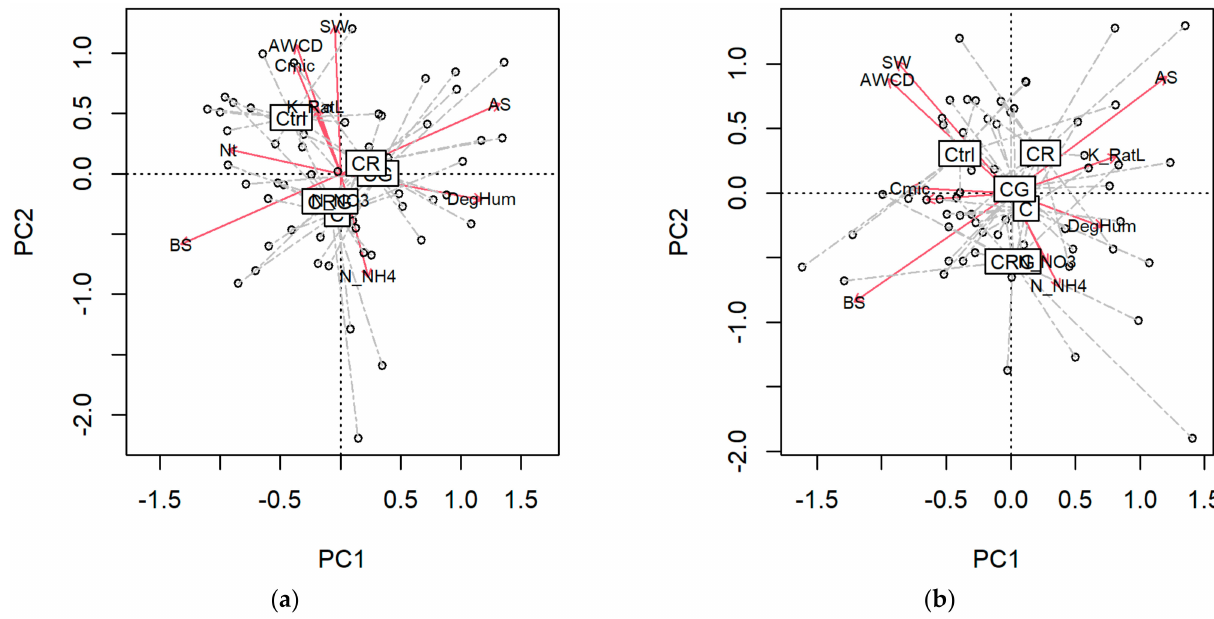
Figure 3. The ordination plot of the diversity indices and soil parameters measured ( a ) in 2018 and ( b ) as differences between 2018 and